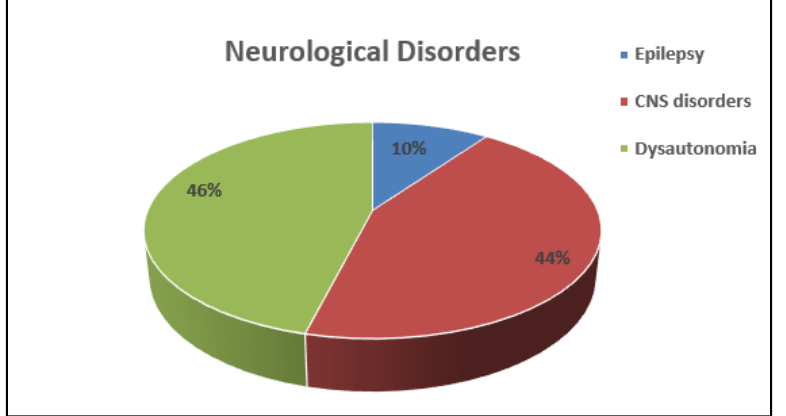
Figure 6. Overall (percentage %) distribution of different neurological disorders other than Mi-